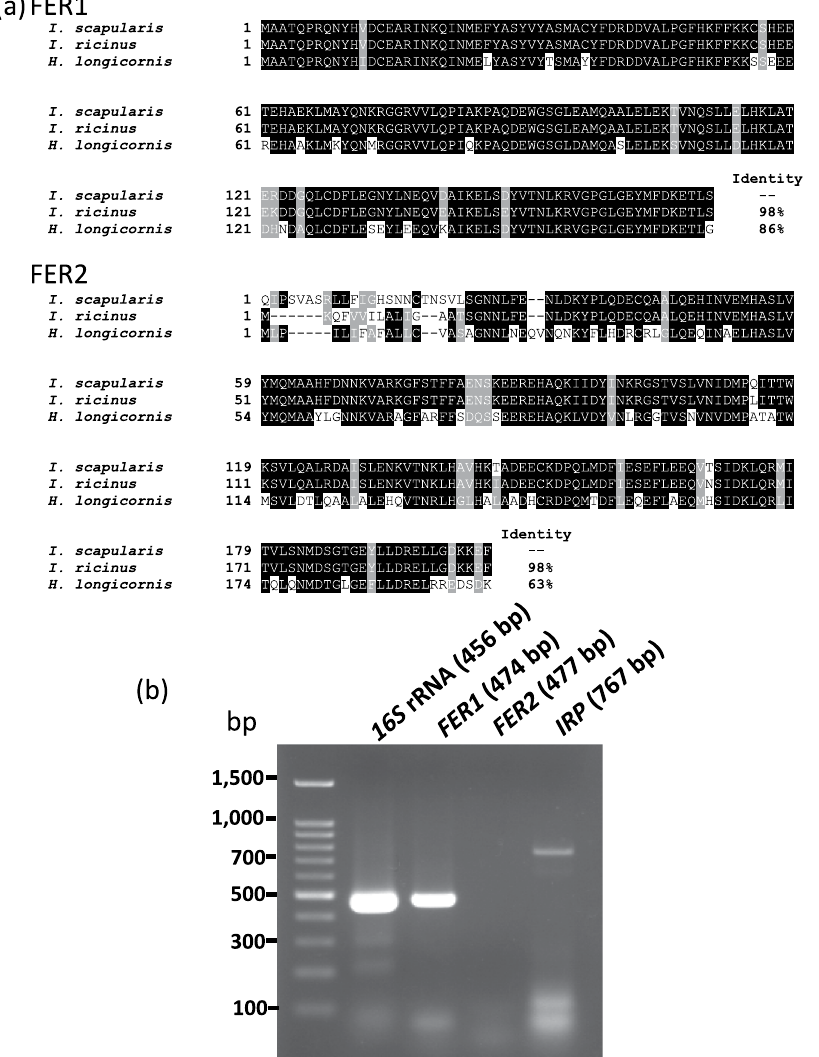
Figure 1. Identification of the ferritin protein and genes of ISE6 cells. ( a ) Multiple sequence alignment of the amino acid sequences of FER1 and FER2 of Ixodes scapularis with Ixodes ricinus and Haemaphysalis longicornis ferritins. Identical residues are shaded black, while similar residues are shaded gray. The percent identities with FER1 and FER2 are placed at the end of the sequences. The GenBank accession numbers of ferritin sequences are as follows: I. scapularis FER1 (AAQ54714.1), I. scapularis FER2 (XP_002415446.1), I. ricinus FER1 (AAC19131.1), I. ricinus FER2 (ACJ70653.1), H. longicornis FER1 (AAQ54713.1), and H. longicornis